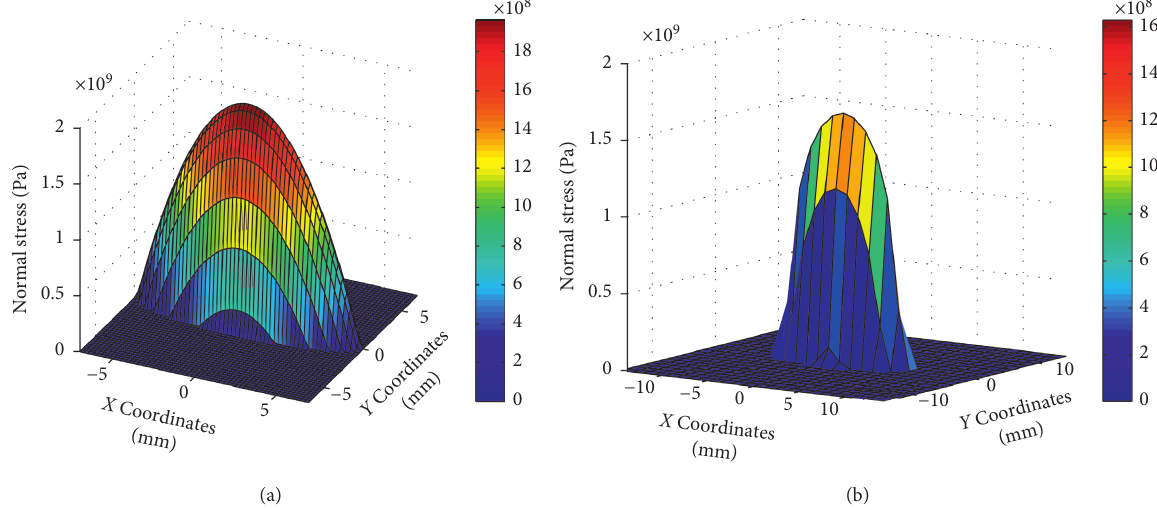
Figure 2: Contact pressure distribution (wheelset transverse displacement is − 3mm) based on: (a) Hertz; (b)